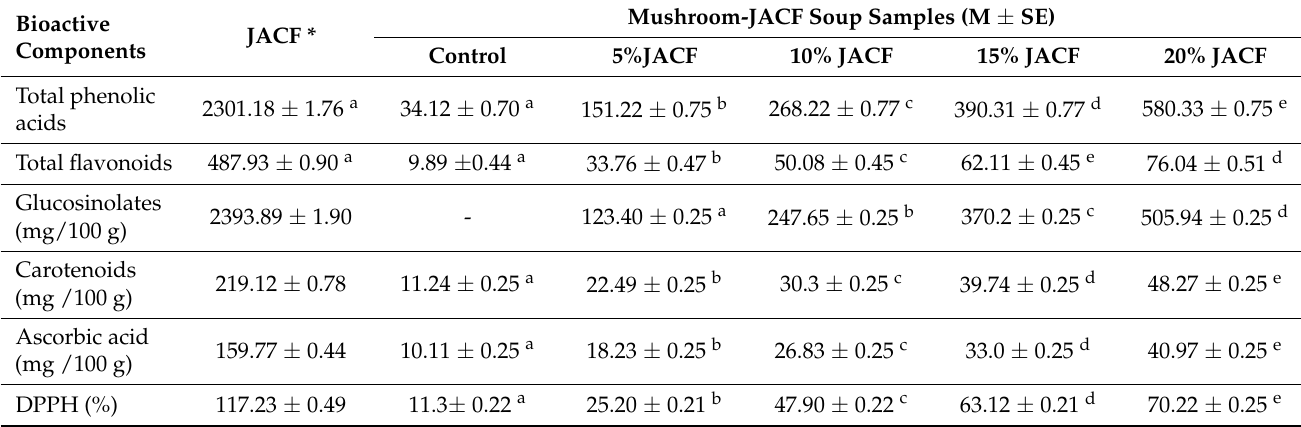
Table 5. Phytochemicals and antioxidant activity of JACF and mushroom-JACF soup